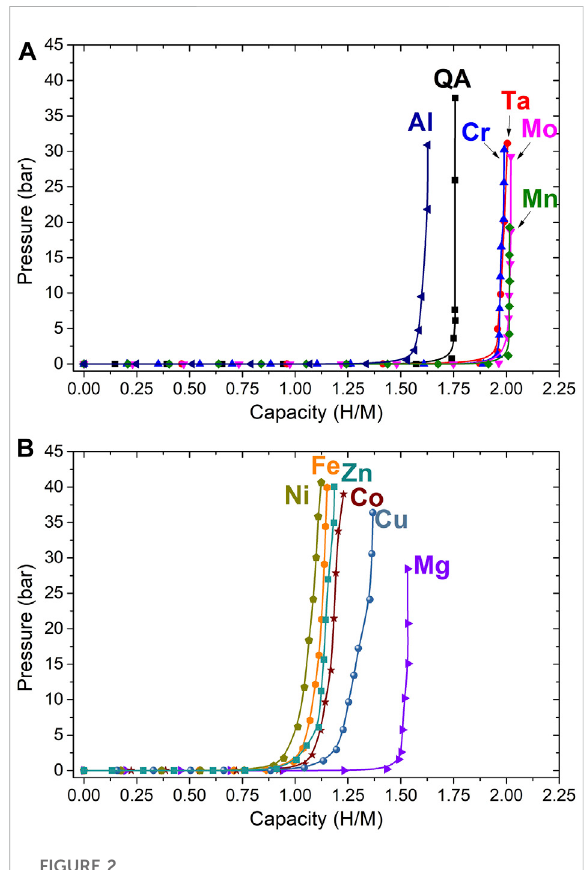
FIGURE 2 PCI curves at 25 ° C for arc melting alloys (A) and reactive ball milling compositions (B) . The PCI curve of the pristine quaternary alloy (QA) prepared by arc melting is also